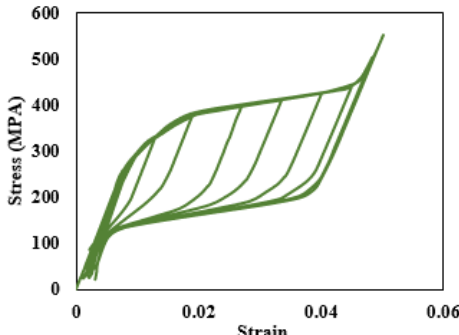
Figure 8. Strain – stress distribution of SMA T-stub under cyclic loading. Figure 8. Strain–stress distribution of SMA T-stub under cyclic